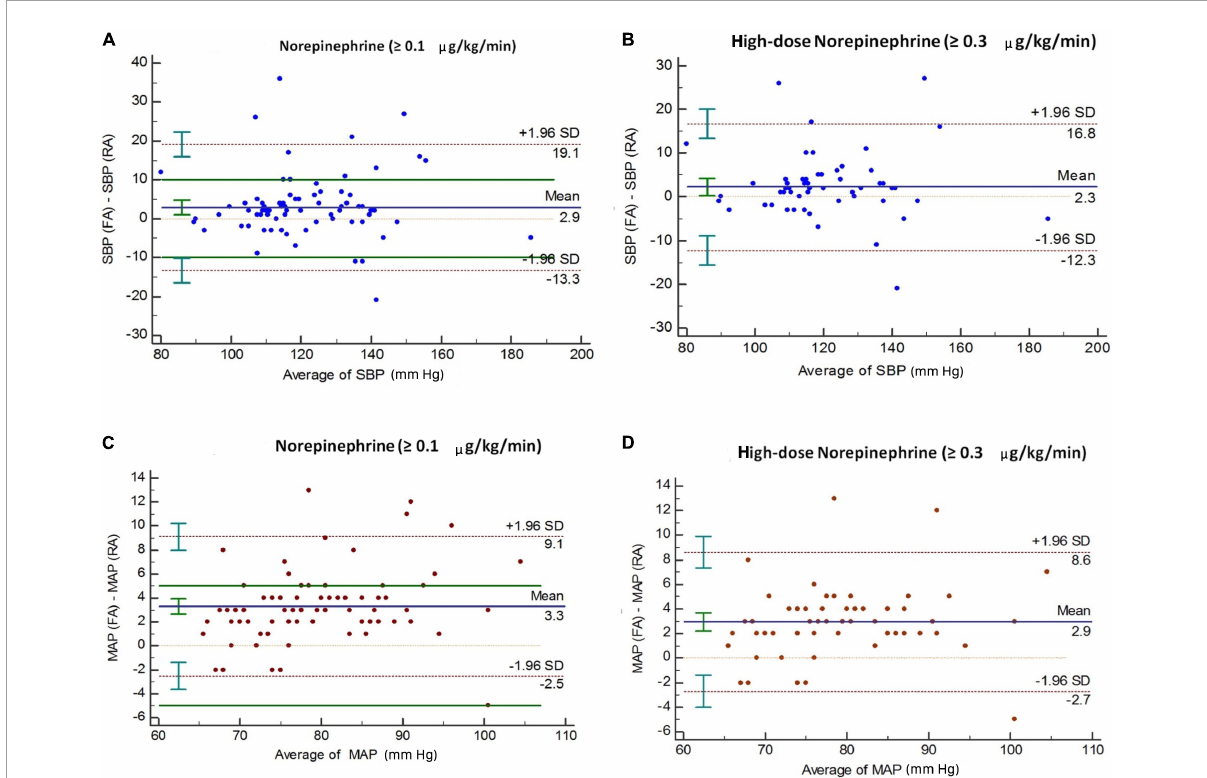
FIGURE2 Bland–Altman analysis of differences between femoral and radial arterial pressure among all patients ( n = 80), and among those on high-dose norepinephrine ( n = 59). Panels (A,B) represent SBP; panels (C,D) represent MAP. The solid line represents bias (the mean difference between simultaneous measurements). Dotted lines show 95% limits of agreement (bias ± 1.96 SD). SBP, systolic blood pressure; MAP, mean arterial pressure.